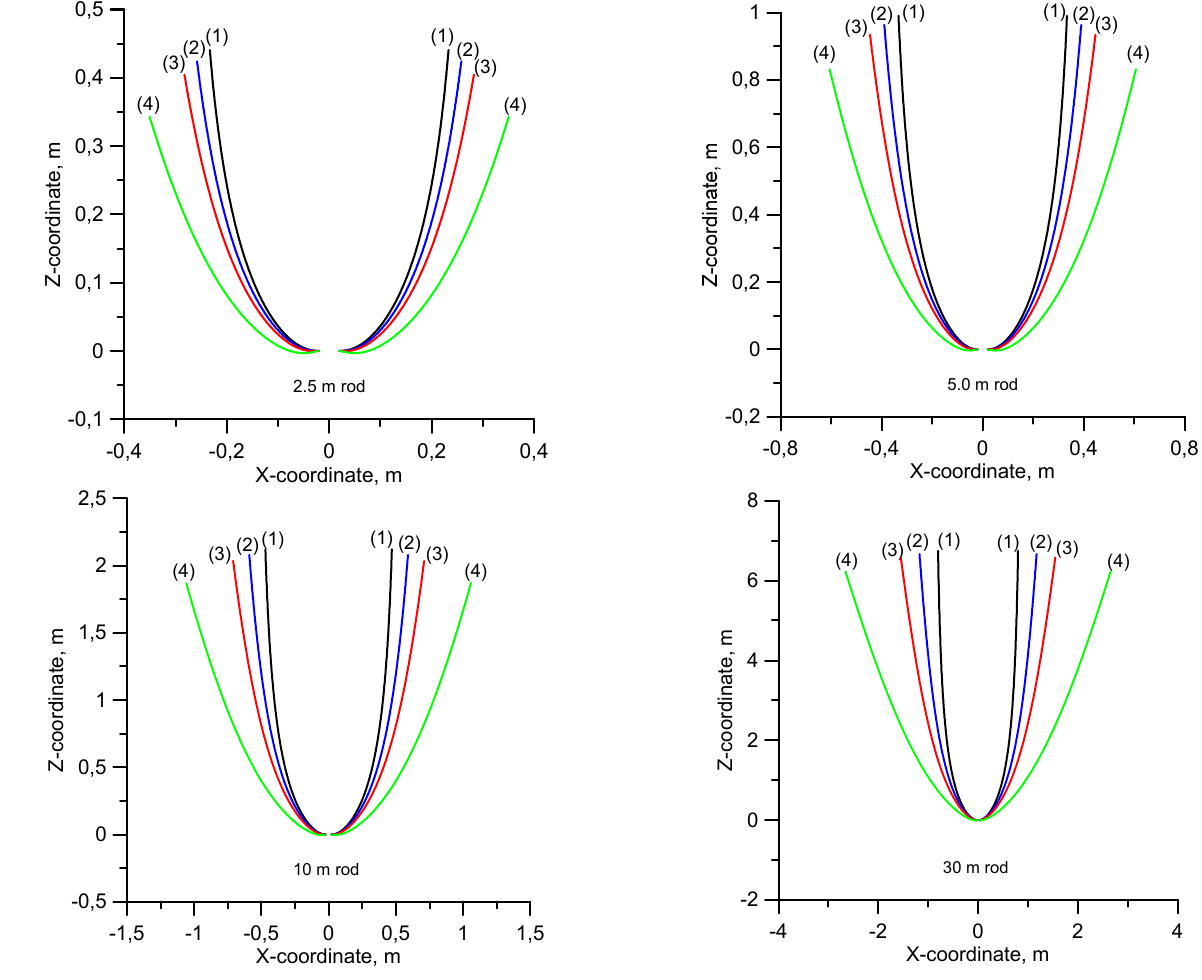
Figure 4. The outer extremity of the streamer zone generated by rods of different heights (marked in the plots), of 2 cm radius, when exposed to an electric field of 100 kV/m. The different curves correspond to different streamer branching lengths. The curves marked (1) in the diagram correspond to streamers moving without branching. Curves (2–4) correspond to branching lengths of 10 mm, 5 mm and 2 mm, respectively.